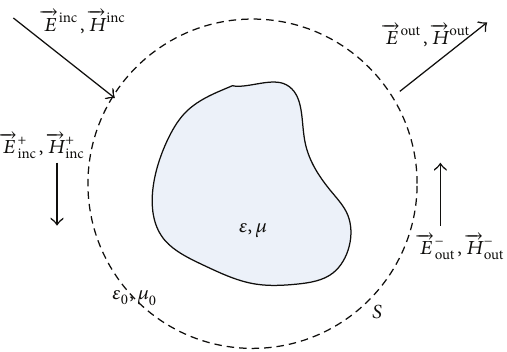
Figure 1: A target object in free space bounded by a reference